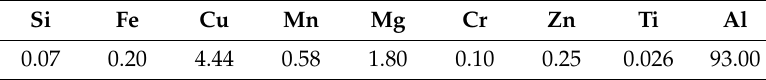
Table 1. AA2024-T3 chemical composition (wt.